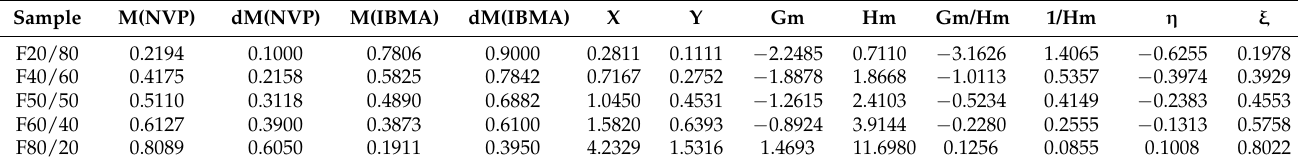
Table 2. Copolymerization data for the free radical copolymerization of NVP and IBMA.